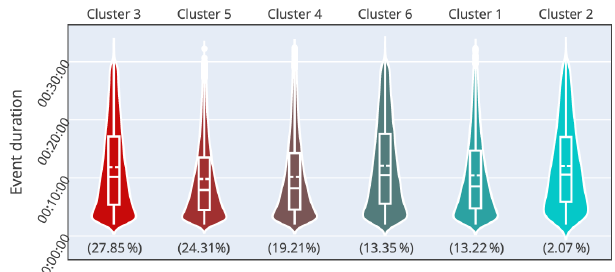
Figure A8. The TED method samples events in temperature time series and applies a k -means clustering on event statistics. Clusters are ranked by fraction of total events, shown as percentage below the violin-box-plot distribution of the event